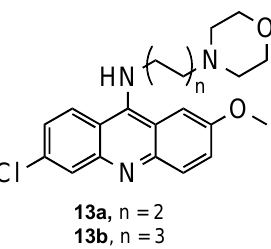
Figure 8. Most promising compound 13 developed by Yu and co-workers [18].